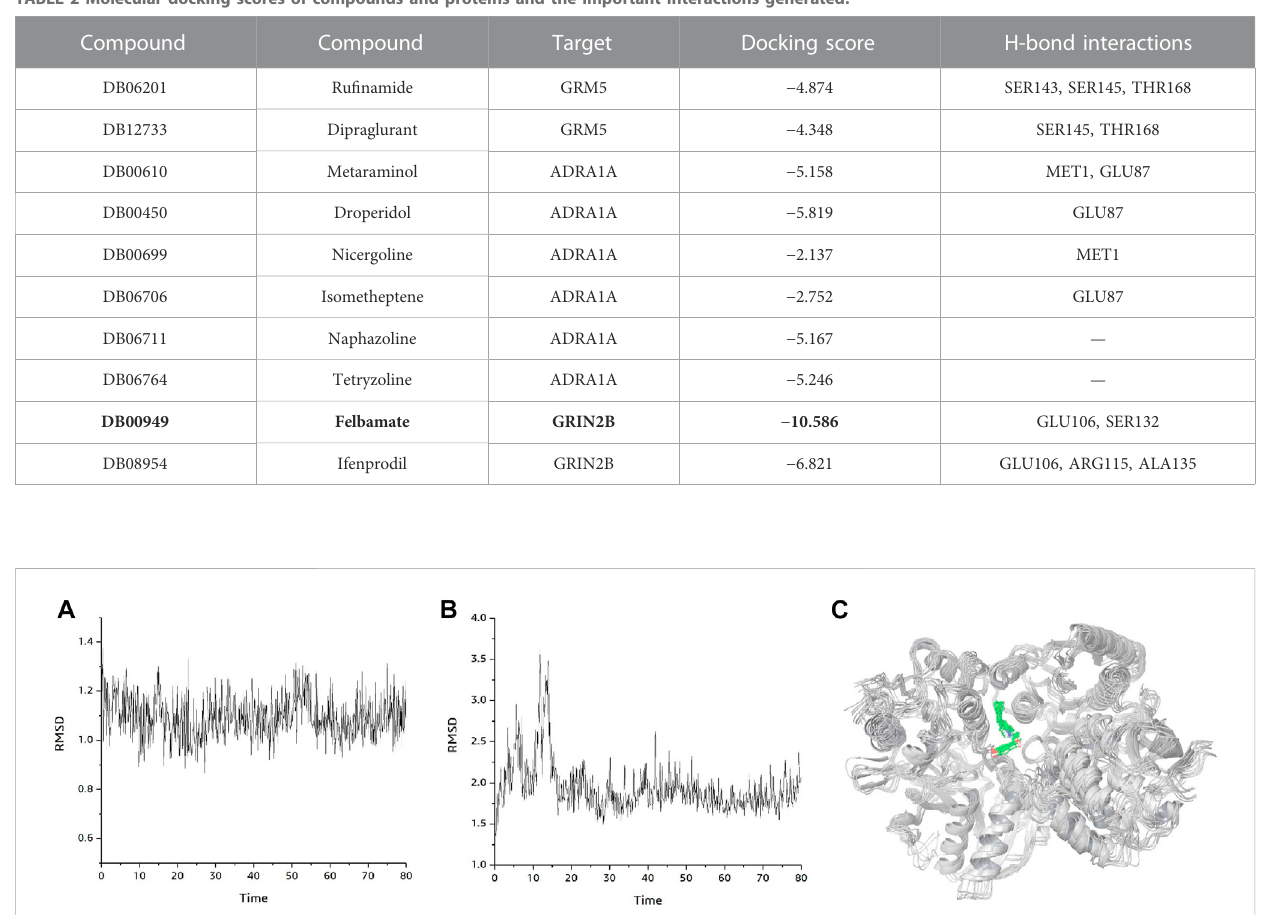
FIGURE 6 Binding mode plot of GRIN2B protein with compound DB00949(Felbamate). (A) RMSD diagram of GRIN2B protein during 80 ns molecular dynamics simulation. (B) RMSD values of compound DB00949 (Felbamate) during 80 ns molecular dynamics simulation. (C) Plot of the dynamic